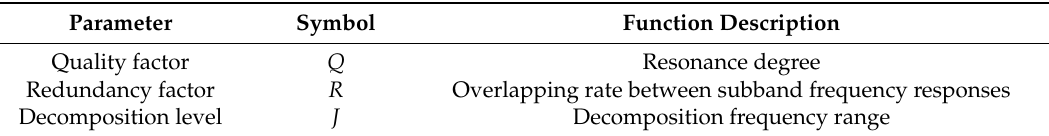
Table 1. Summary of parameters in TQWT.